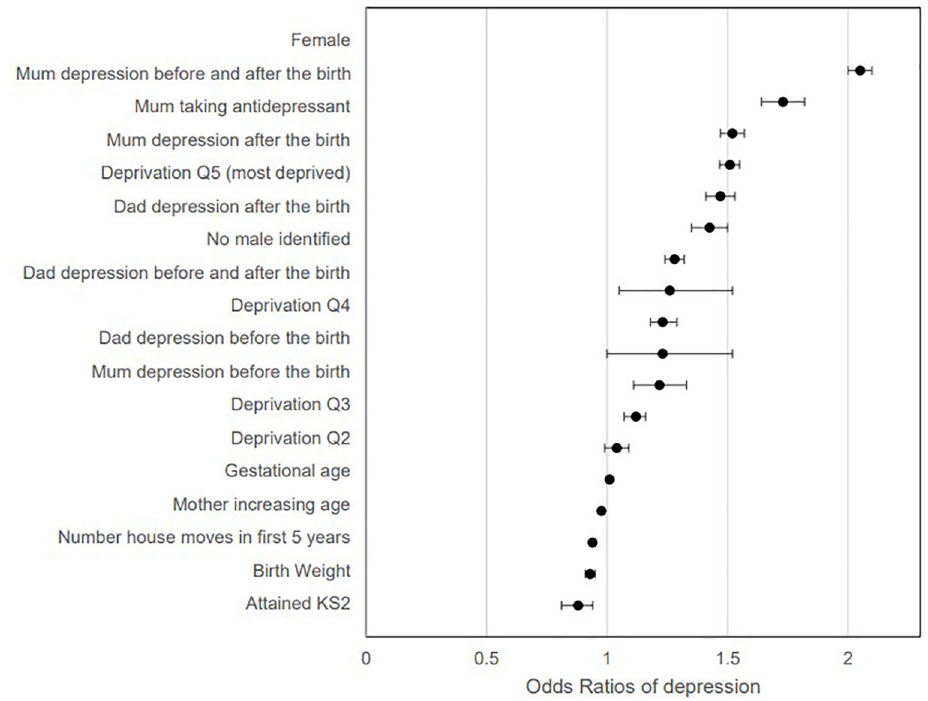
Fig 1. Cox regression of all factors associated with depression in children. Note: Quintile Q5 most deprived and Q1 least deprived. Attained KS2 is achieved educational milestones at age 10–11.